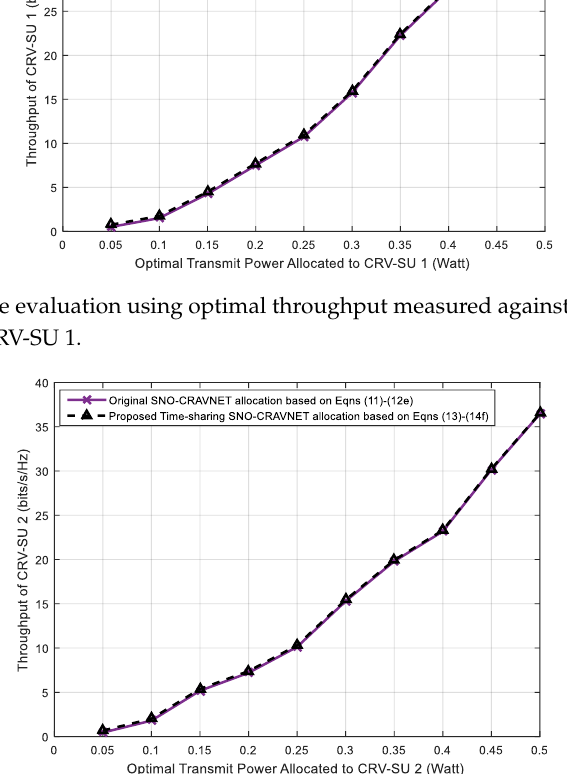
Figure 9. Performance evaluation using optimal throughput measured against the optimal supplied transmit power for CRV-SU 2.